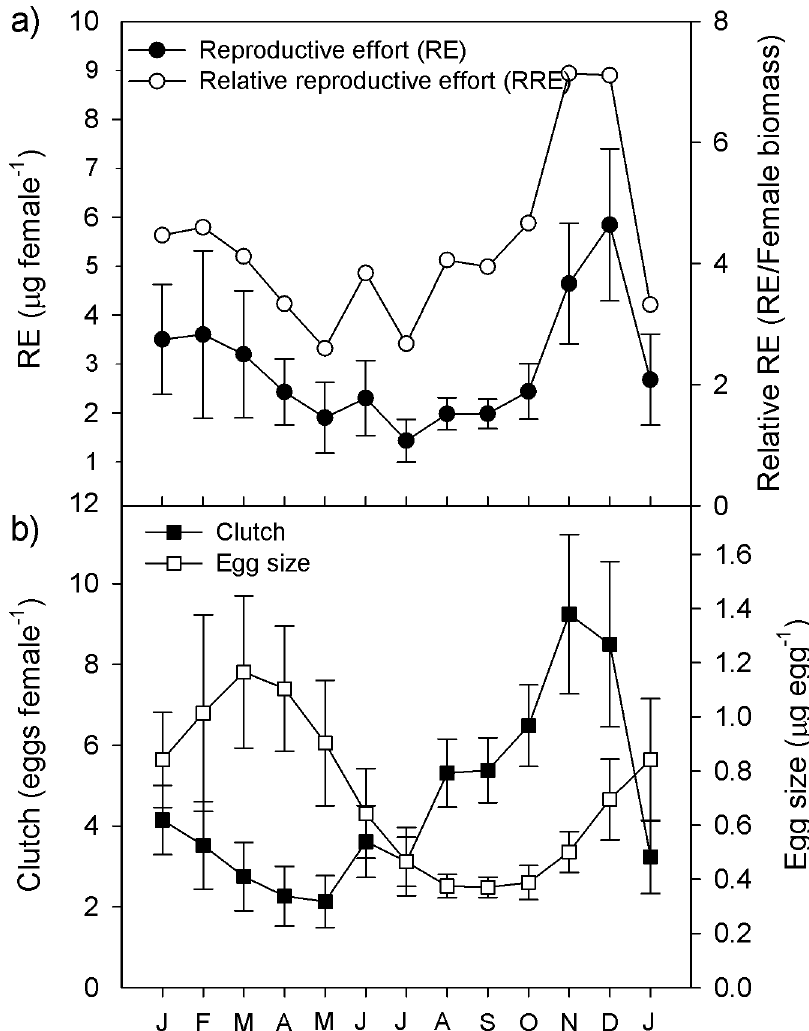
Fig 3. Temporal dynamics of life-history traits of L . garciai in Lake Alchichica. a) Average reproductive effort, i.e. the absolute quantity of biomass a female invests per clutch; and relative reproductive effort, the proportion of the female biomass invested per clutch. b) Average number of eggs per sac and average size of those eggs. Vertical bars indicate ± one standard deviation.